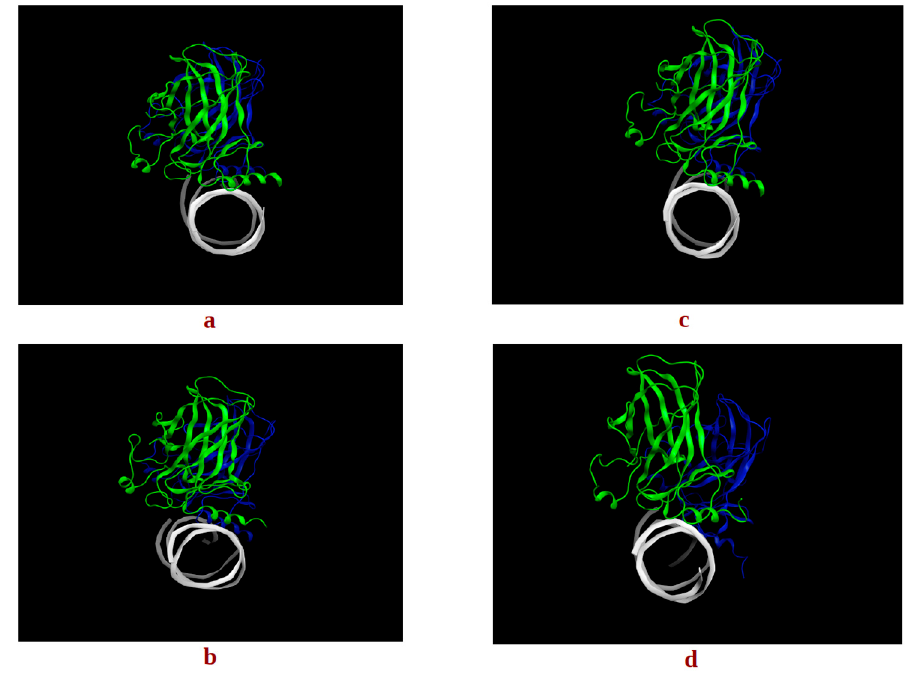
Figure 5. The centroids of the two most populated clusters, ( a ) wt-1 and ( b ) wt-2 of the wt-p53 dimer and ( c ) mt-1 and ( d ) mt-2 of the G245S-mp53 dimer. The rotation of monomer B in the mutant is evident in mt-2 in monomer B (blue) relative to monomer A (green).